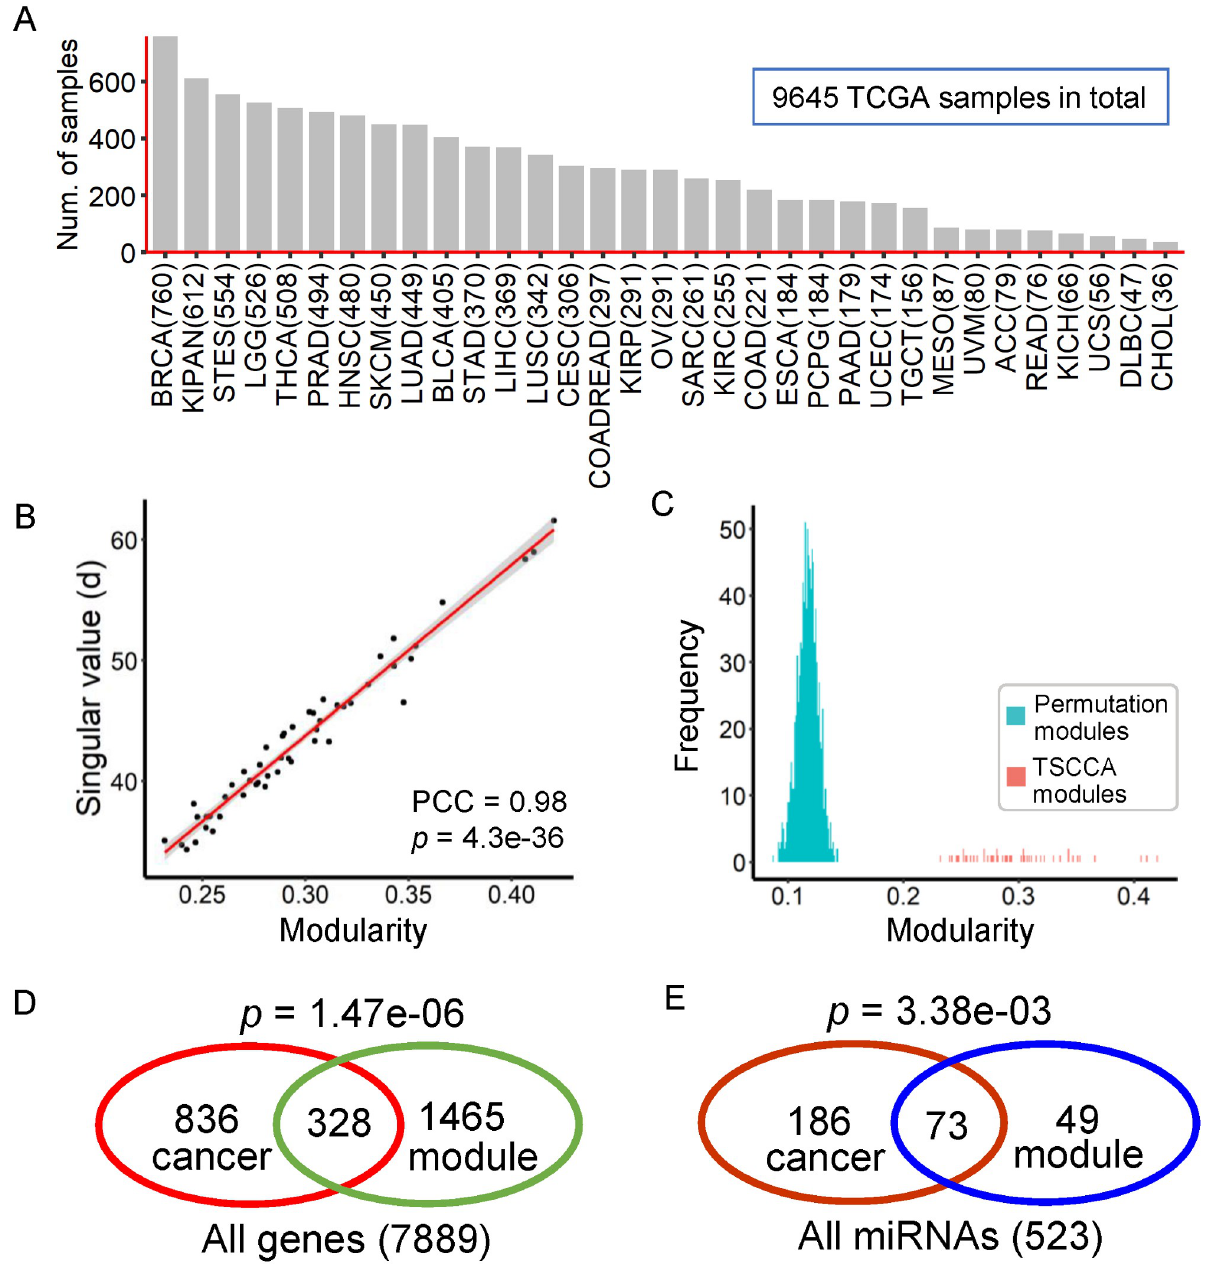
Fig 2. Application to the TCGA data from multiple cancers. (A) Number of cancer patients or samples on 33 cancer types from TCGA in this study. (B) Correlation between the modularity scores of identified modules ( y -axis) and the corresponding singular values (objective function values) ( x -axis) with PCC r = 0.98. (C) Distribution of modularity scores. The modularity scores of identified modules are significantly greater than those of random ones (Permutation test P < 0.05/50 for each identified module). (D) Among the 1793 genes from all the identified modules, 328 are reported to be related with cancer (Hypergeometric test P = 1.47e-06). (E) Among the 122 miRNAs from all the identified modules, 73 are reported to be related with cancer (Hypergeometric test P = 3.38e-03).